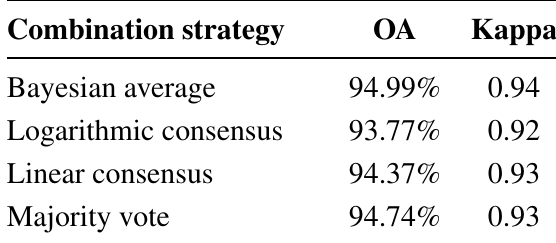
Table 5. Classification accuracy of parallel classifiers